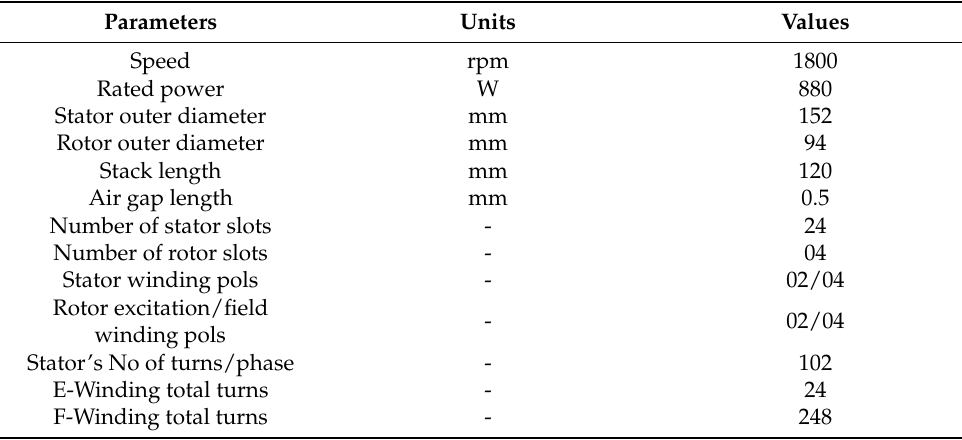
Figure 7. Machine model of ( a ) reference machine and ( b ) proposed machine. Table 1. Parameters for analysis of synchronous machines.